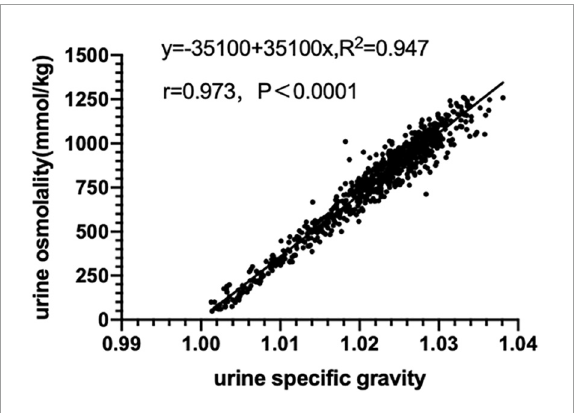
FIGURE2 Relationship between urine specific gravity and urine osmolality ( n = 803).